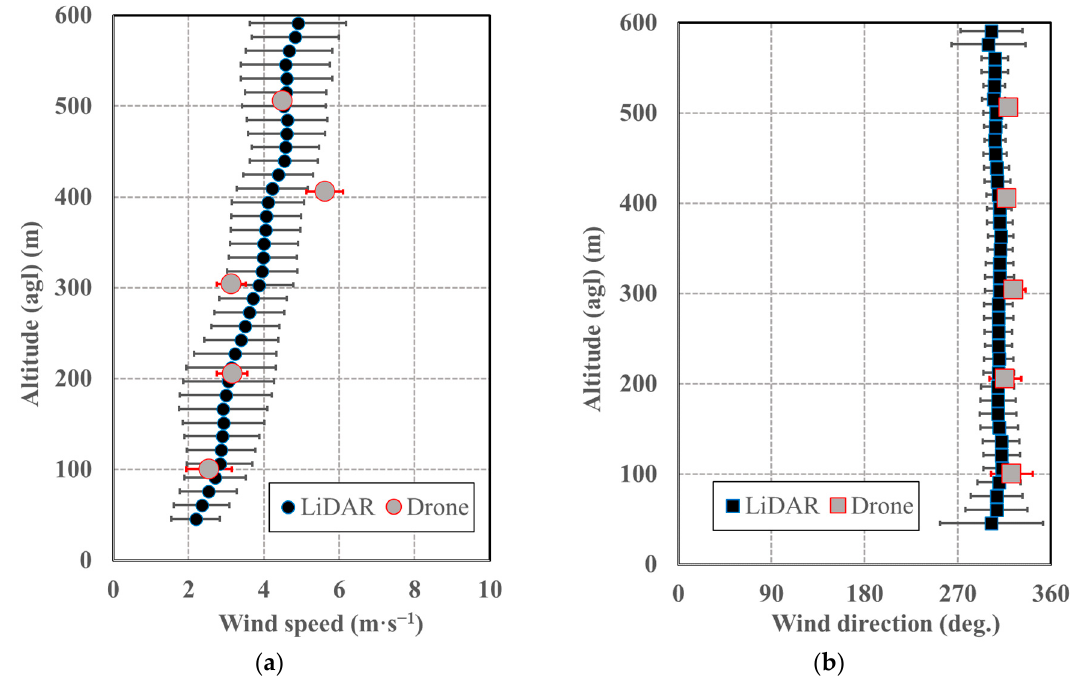
Figure 6. Comparison between hovering drone (Protocol A) and Doppler light detection and ranging (LiDAR) observations for: ( a ) wind speed and ( b ) wind direction for Run B-4.